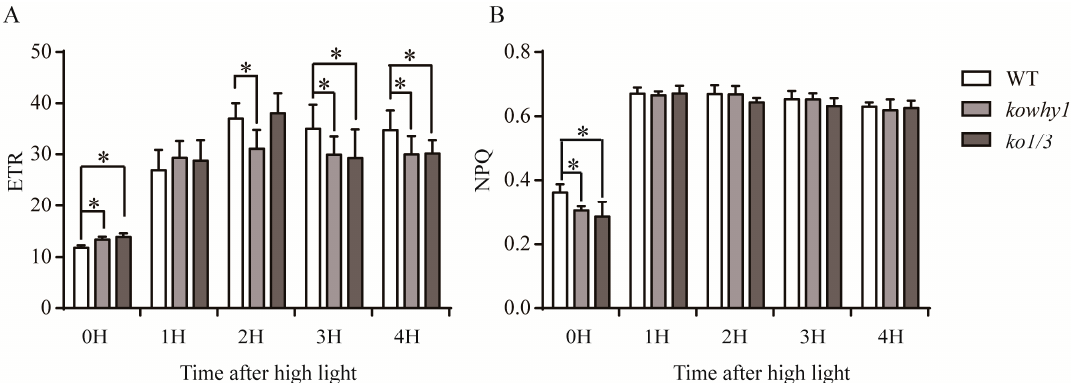
Figure 6. Measurement of photosynthetic parameters in WHY mutants and wild-type plants after high light treatment. ( A ) Electron transport rate (ETR) in WHY mutants and wild-type plants under high light; ( B ) Non-photochemical quenching (NPQ) in WHY mutants and wild-type plants under high light. Means ± SE of at least 10 independent measurements are shown. Asterisk indicate significant differences compared to WT (* p < 0.05, Student’s t test).